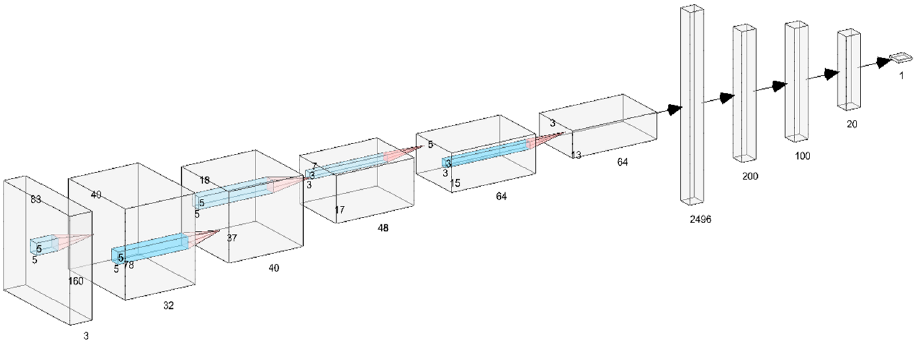
Figure 5. Final CNN architecture.